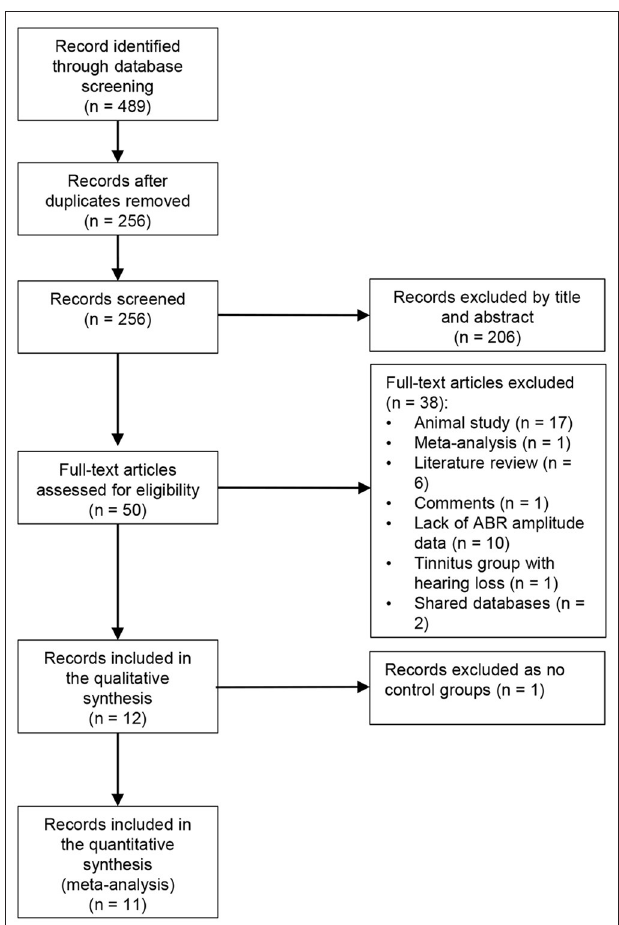
FIGURE 1 | Flow diagram of study selection (following